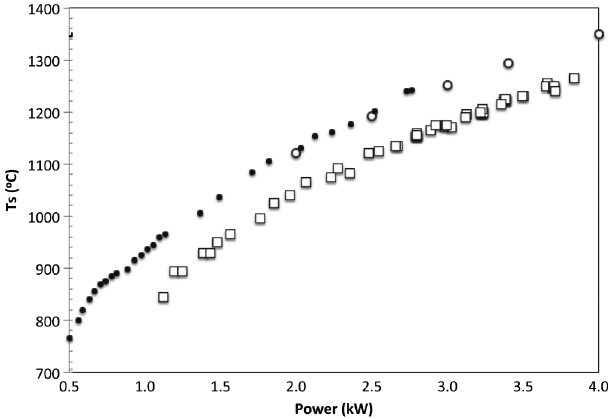
FIG. 4. The modeled and measured lithium ion source surface temperature (vs filament power) for the NDCX-II emitter are compared. The open circles are from the ANSYS steady-state finite-element model of the filament power dissipation in the injector. The solid black line is an empirical power-law fit to the model. The measured temperature of the uncoated substrate (closed circles) is in excellent agreement with the model. The pyrometer indicated temperature of the coated source (squares) is about 75 (cid:1) C lower than the temperature of the uncoated